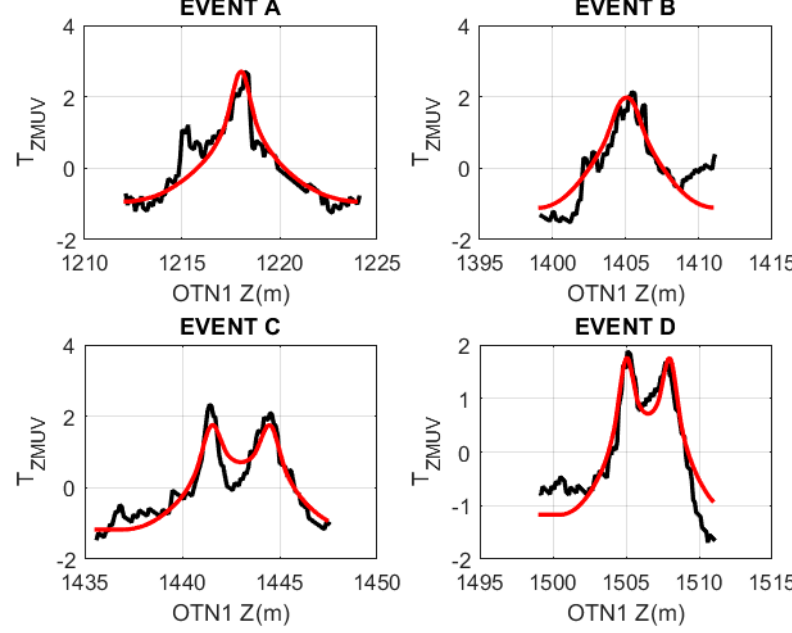
Figure 16. Following Figures 11 and 14, overlays of Figure 14 model wellbore axial temperature profiles (red traces) for 100 cm radius wellbore embedded in a 10-m radius crustal volume superposed on OTN1 wellbore temperature events A, B, C, and D (black traces). Horizontal axes give wellbore depth in meters; vertical axes are wellbore temperature profiles normalised to zero-mean/unit-variance. ( Upper Left ) Model temperature profile computed for single 0.6 m thick flow channel. ( Upper Right ) Model temperature profile for 2–3 m thick flow channel. ( Lower Left ) Model temperature profile for 4-m spaced pair of 0.6 m thick flow channels. ( Lower Right ) Model temperature profile for 3-m spaced pair of 0.6 m thick flow channels.